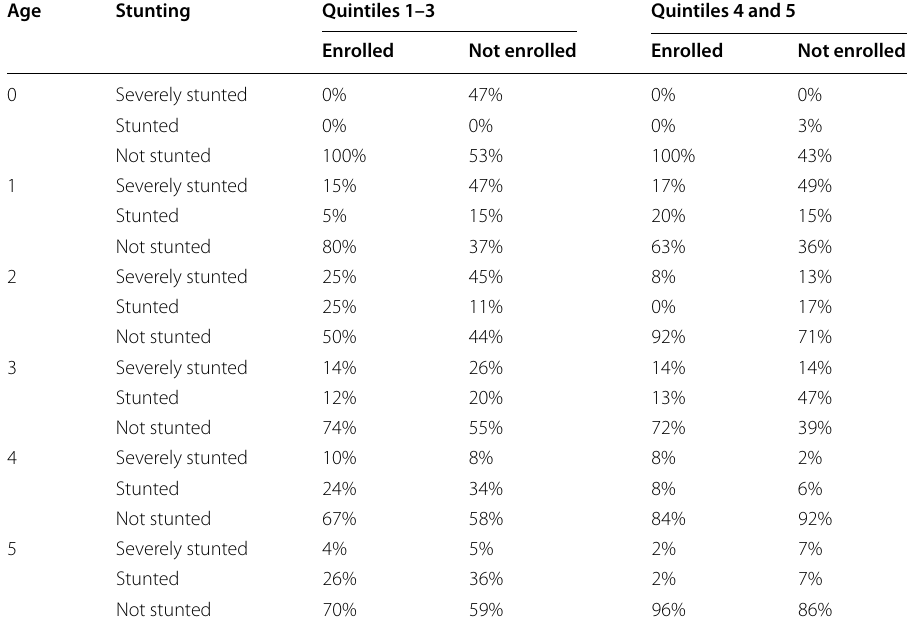
Table 12 Average percentage of children classified as stunted by age in years, socio-economic quintile, and ECD enrolment